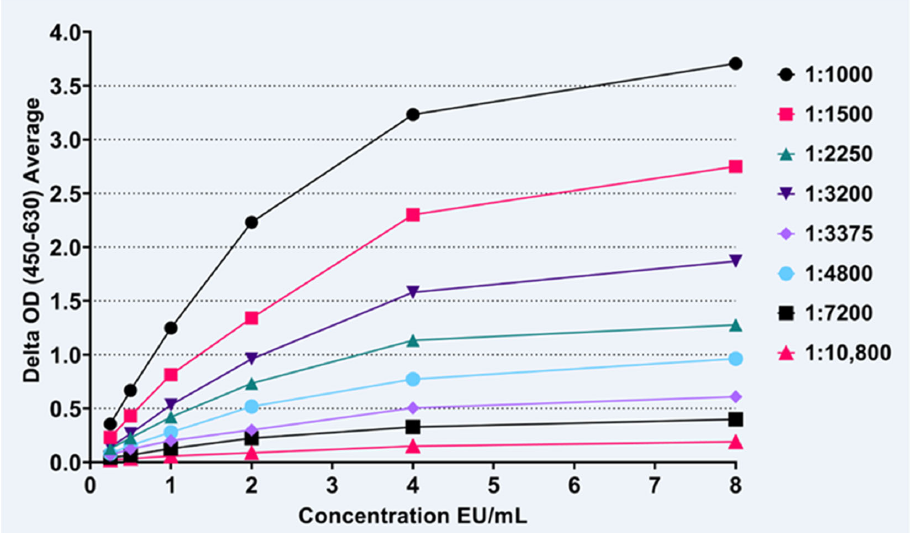
Figure 2. Anti-human IgM-HRP conjugate was tested, in dilutions ranging from 1:1000 to 1:10,800, against sample RAE-21 (estimated at ~8 EU/mL based on the RFFIT results) in serial two-fold dilutions, to identify the optimal concentration for the IgM ELISA.